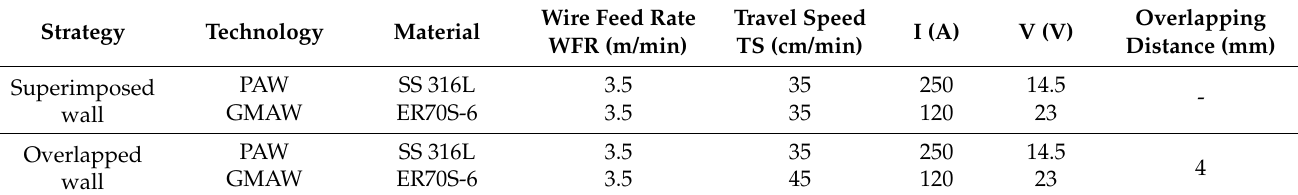
Table 2. Process parameters for additive manufacturing of different